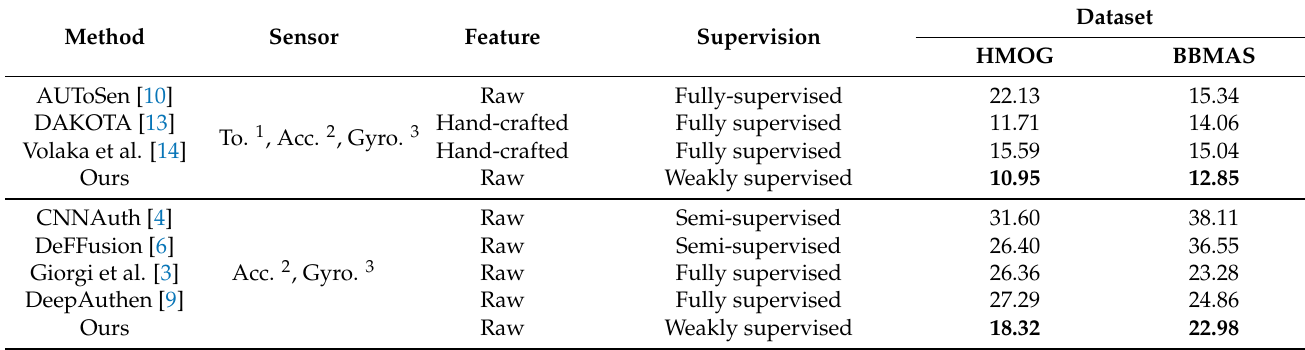
Table 4. Averaged EERs (%) of SOTA methods.